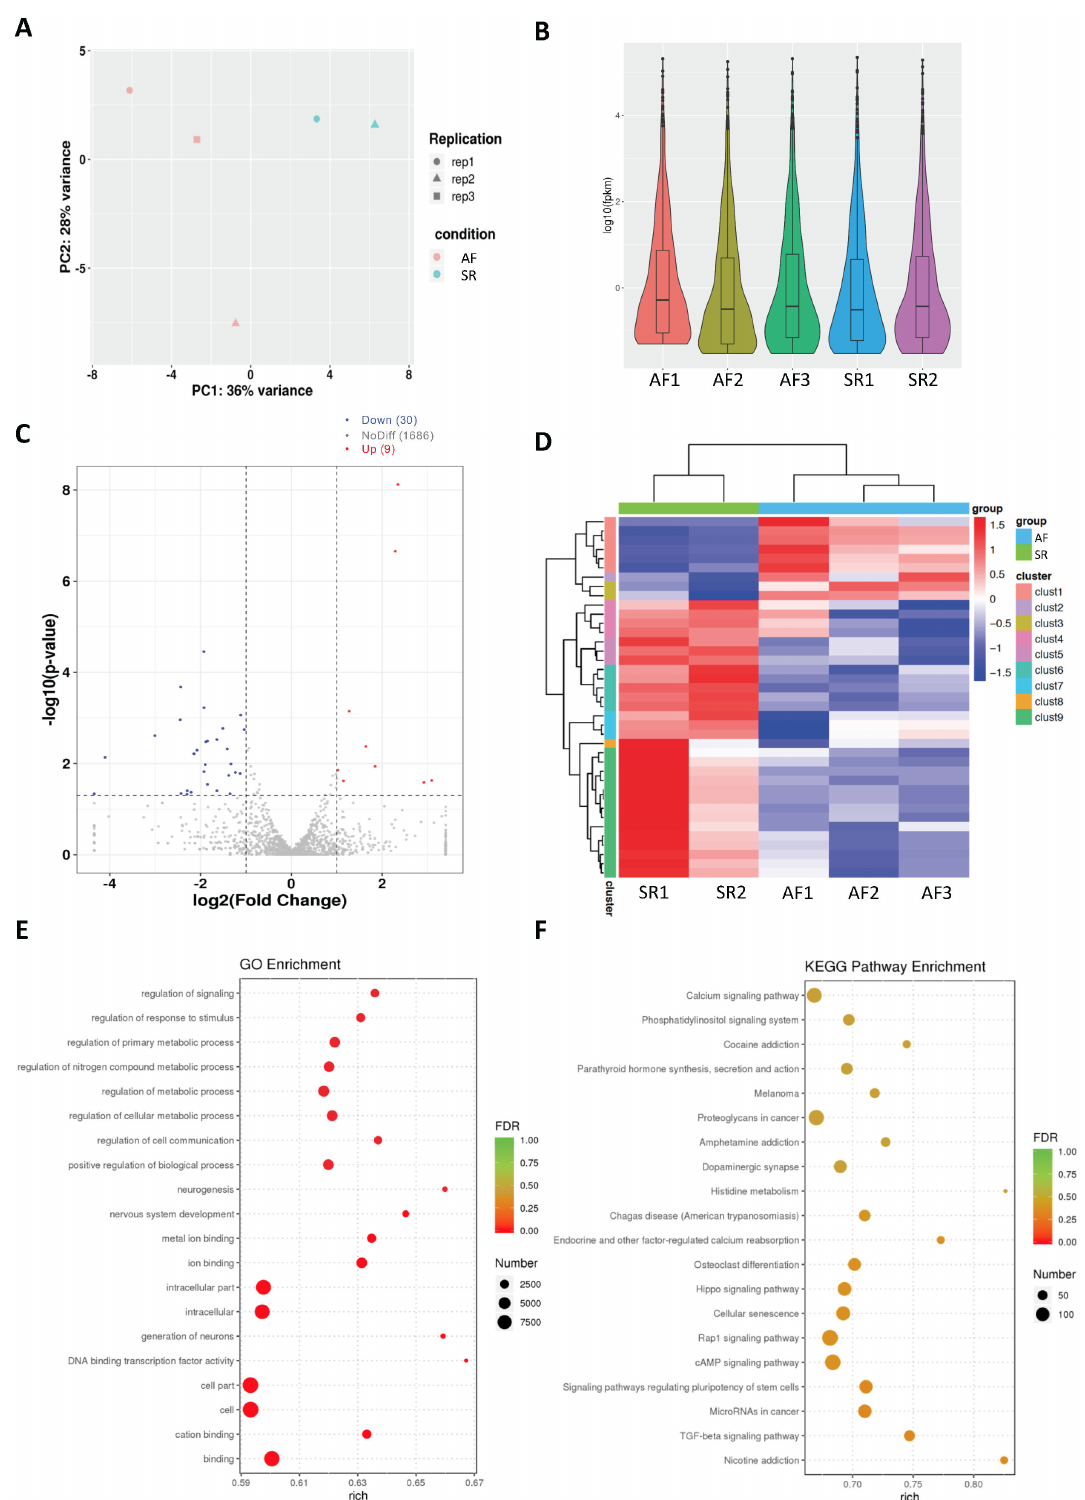
Figure 2. miR-Seq analysis for DEGs in the SR control and AF groups. ( A ) PCA analysis of SR and AF patient samples. ( B ) The average number of miRs analyzed from patients and the ctrl group in miR-seq. ( C ) Volcano plot shows significantly upregulated (red), downregulated (blue), and non-significant miRs (grey). Significant miRs are selected based on |log 2 FoldChange| > 1 and p < 0.05. ( D ) Heat map matrix shows clustering of differentially expressed miRs between the SR and AF groups. ( E ) GO and ( F ) KEGG pathway enrichment analysis of top deregulated